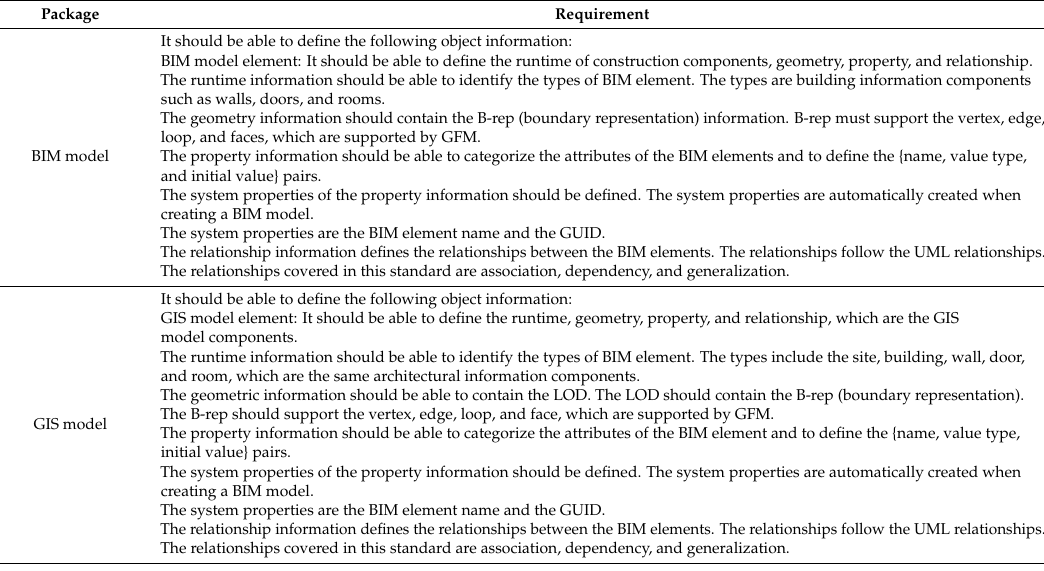
Figure 7. BIM and GIS concept model and B2GM package diagram. Table 3. Package requirements.